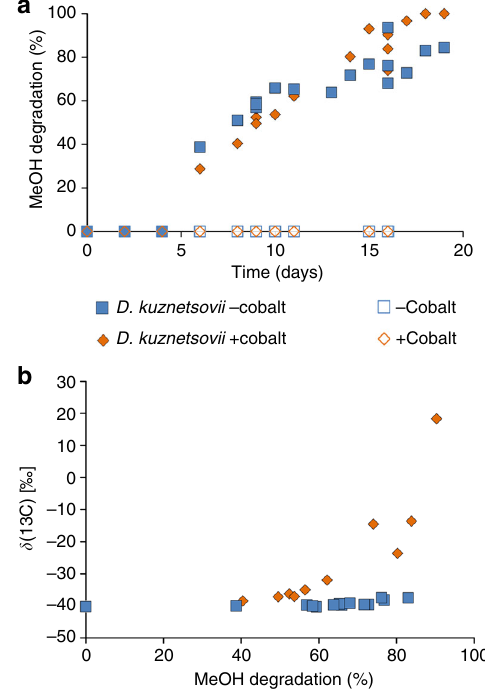
Fig. 5 Stable carbon isotope fractionation analysis of D. kuznetsovii . a Percentage of methanol degraded in time. b SCIF analysis data, presented as the delta 13 C fractionation values of methanol set out against the methanol degradation. Open symbols are controls without